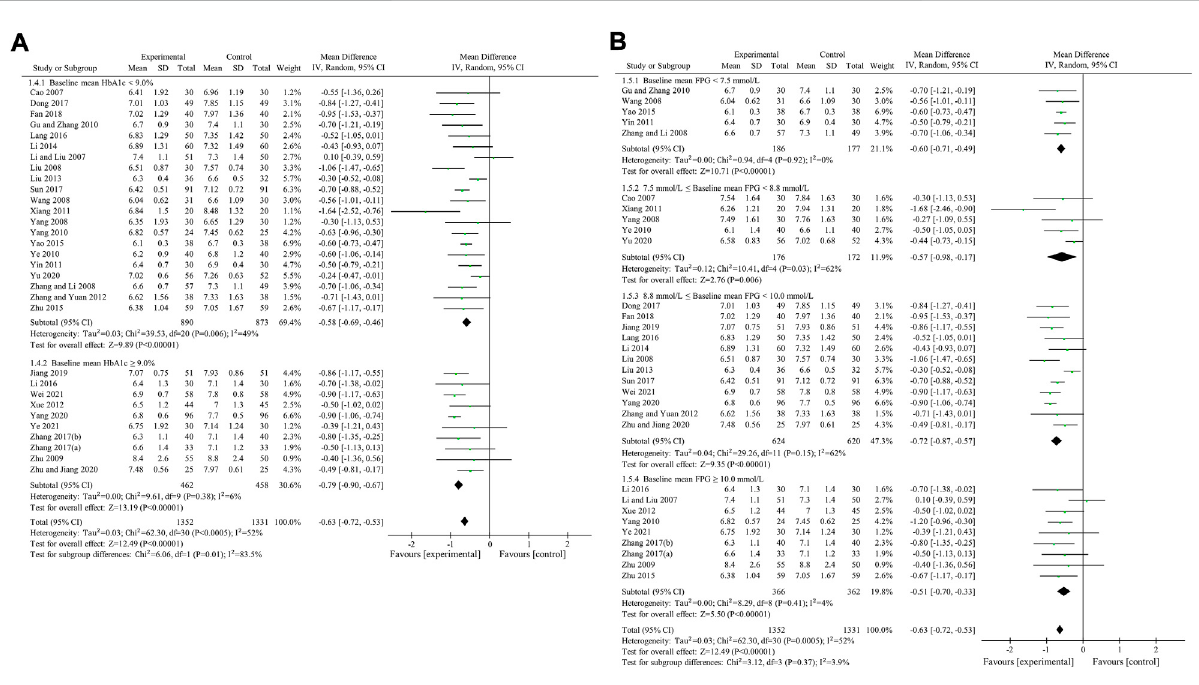
FIGURE 6 Meta-analysis of the effect of BBR on HbA1c. (A) Subgroup analysis according to baseline mean HbA1c. (B) Subgroup analysis according to baseline mean